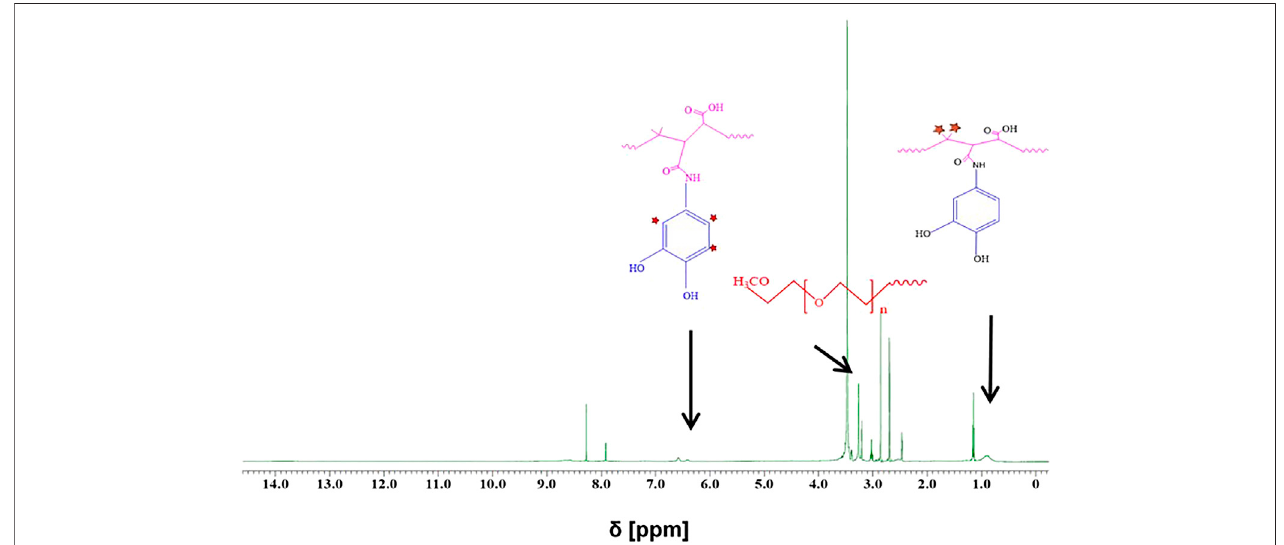
FIGURE 3 | H-NMR spectra of dopamine – PMA – PEG in DMSO-d6. Multiple peaks at chemical shift δ (cid:2) 6.32 – 6.78 ppm and a broad peak at ∼ 0.9 ppm are, respectively, ascribed to the aromatic protons of catechol and methyl groups in the PMA backbone. The sharp peak at around 3.3 ppm corresponds to the methoxy groups of PEG (H 2 N – PEG –